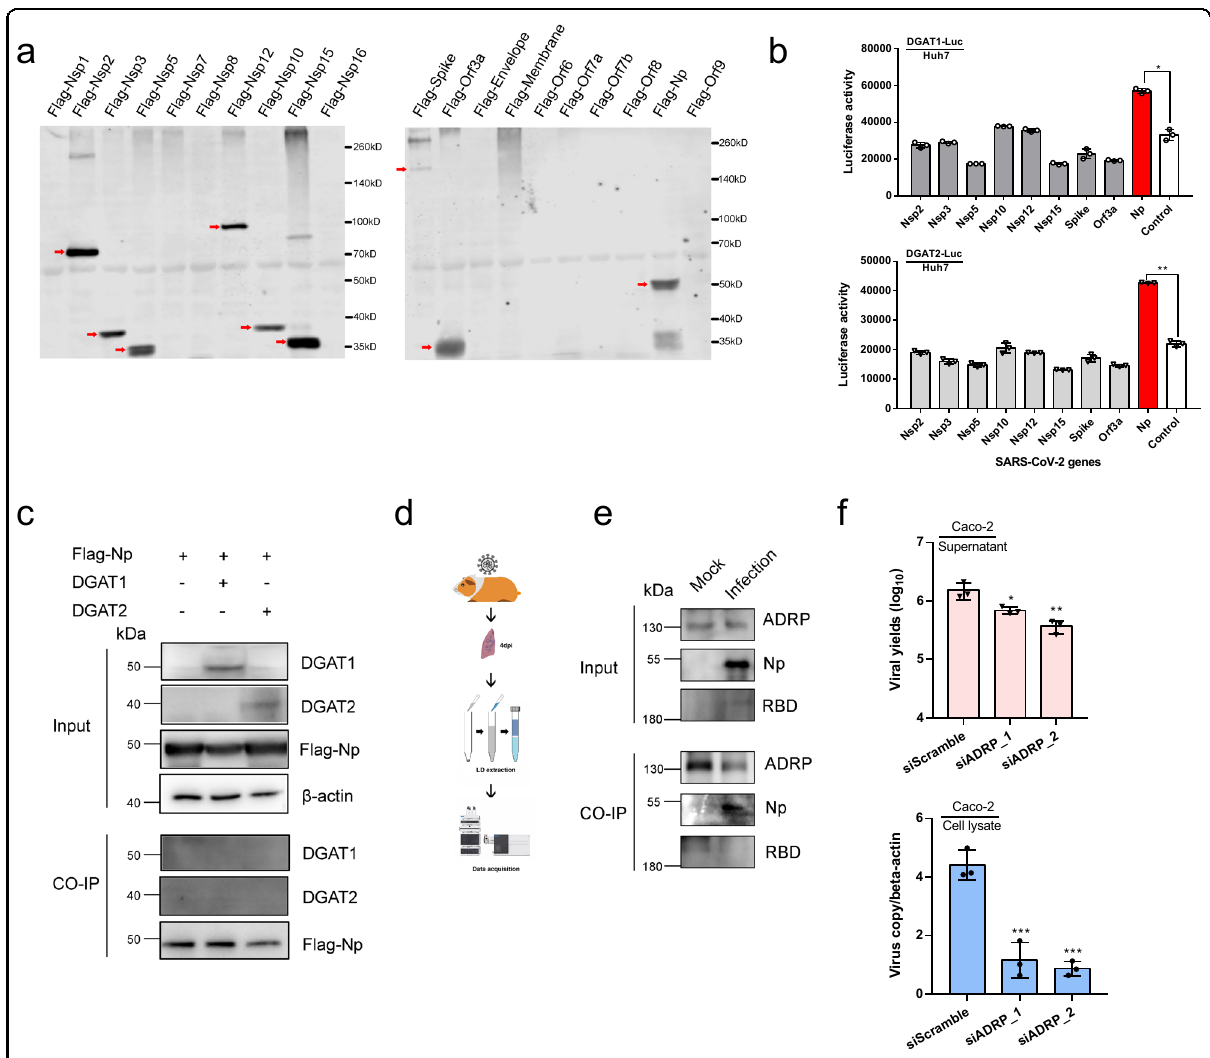
Fig. 4 The interplay between SARS-CoV-2 and LDs-relevant host factors. a Expression of individual SARS-CoV-2 protein when co-transfected with the DGAT1 or DGAT2 promoter-reporter plasmid. Shown is the Western blot detecting the viral proteins by anti- fl ag antibody. b SARS-CoV-2-NP trans-activates DGAT1 / 2 genes. Huh7 cells were transfected with the indicated reporter-gene plasmid and viral ORF clones, individually. The luciferase activity re fl ecting DGAT1 (upper panel) or DGAT2 (lower panel) gene expression was determined at 48 hpi. One-way AVONA was used for comparison with the control group. c SARS-CoV-2-NP does not interact with DGAT1 or DGAT2. A co-immunoprecipitation assay was conducted in 293 T cells transfected with NP and either DGAT1/2 plasmids. After pull-down, NP was detected by anti- fl ag while DGAT1/2 was detected by speci fi c antibodies. d Flow chart showing the preparation of hamster lung extracts for identi fi cation of SARS-CoV-2 proteins associated with LDs. e ADRP interacts with viral NP but not spike. A co-immunoprecipitation assay was conducted in infected or non-infected hamster lungs. After pull-down using an anti- ADRP antibody, viral NP or spike (RBD) was detected by speci fi c antibodies. f Knockdown of ADRP gene expression reduced SARS-CoV-2 replication in CaCo-2 cells (0.1 MOI, 48 hpi). Viral yields in the supernatant and cell lysate were determined by RT-qPCR, respectively. One-way ANOVA was used for comparison with the scrambled siRNA pre-treated group. *** P < 0.001, ** P < 0.01, * P <